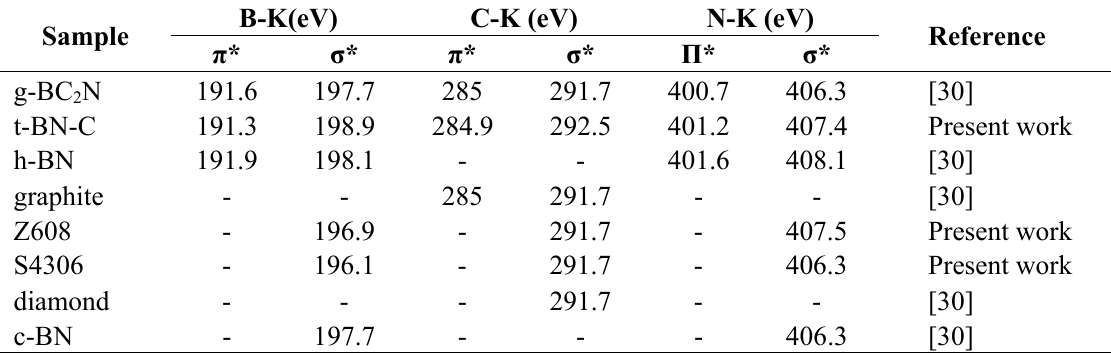
Table 2. A summary of the energy loss values of the present t-BN-C materials in comparison to those of pure h-BN, graphite, graphitic and cubic B-C-N material. The energy positions of the π * and σ * peak maximums in C-K spectra were assumed to be at 285 eV and 291.7 eV,